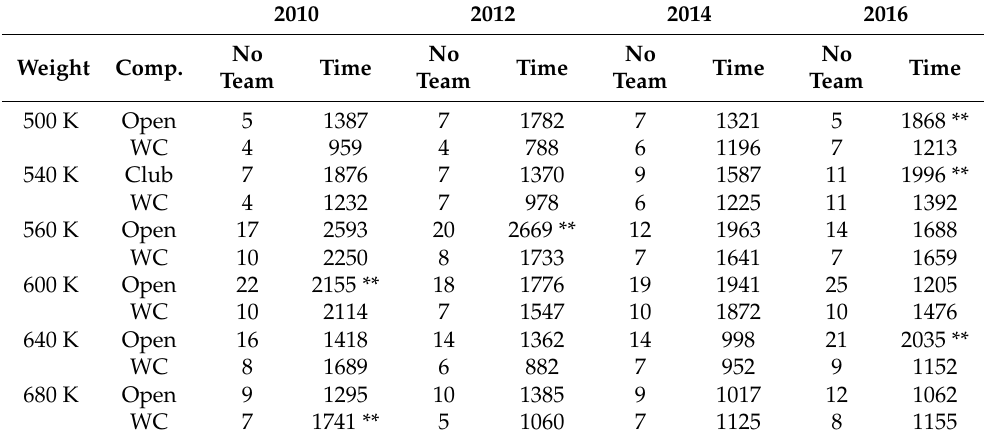
(Table 6). In the same table, it can be observed that the competition volume is lower in the competition for national teams (WC) than in clubs (open). Table 6. Maximum accumulative pulling